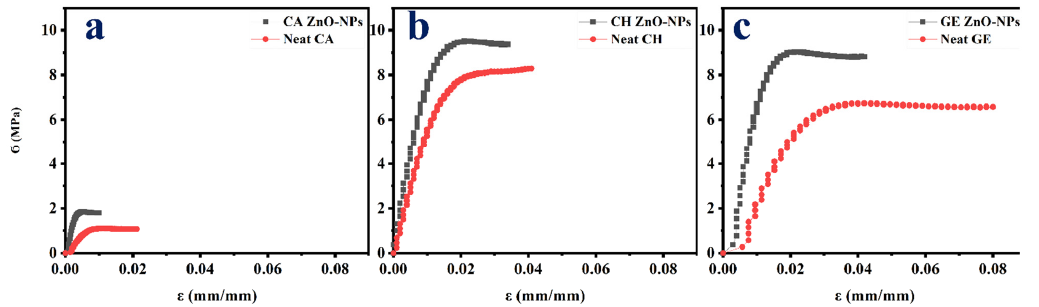
Figure 5. Tensile test profiles of the different films reinforced with ZnO ‐ NPs (1.0% w / w ) ( a ). CA ‐ based, ( b ). CH ‐ based, and ( c ). GE ‐ based film ZnO ‐ NPs). Neat films without ZnO ‐ NPs (CA ‐ based, CH ‐ based, and GE ‐ based neat films) were added as reference.